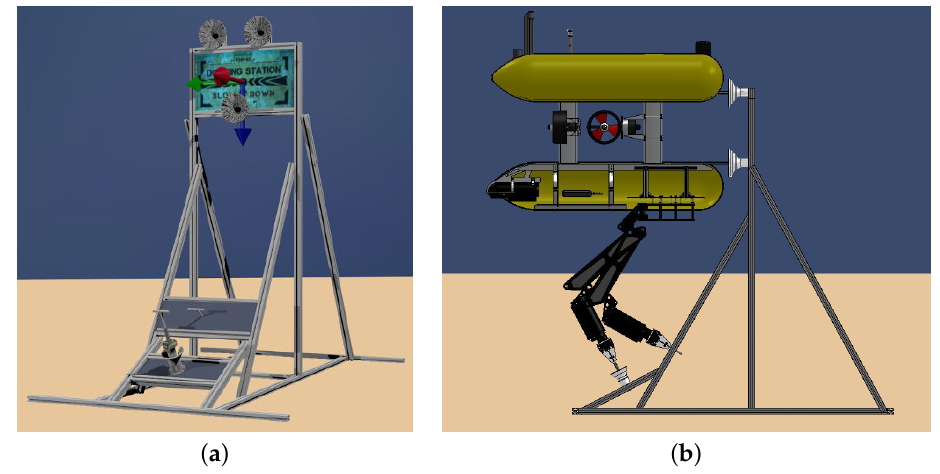
Figure 1. ( a ) schema of the mock-up intervention panel indicating its axis: X in red , Y in green and Z in blue ; ( b ) Girona 500 I-AUV docked in the mock-up